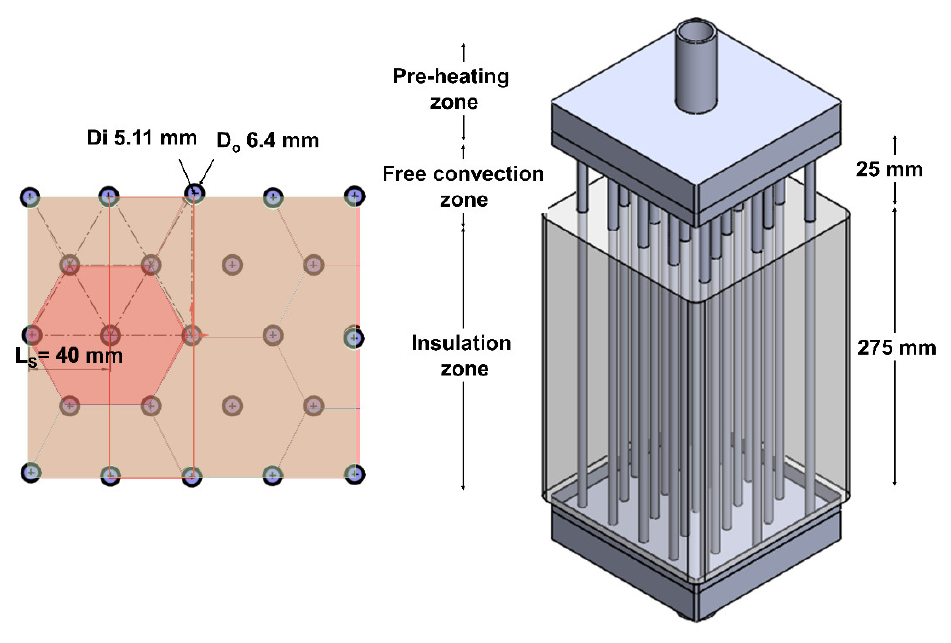
Figure 7. A schematic representation of the scaled-up multi-tubular fixed-bed reactor. Table 6. Dimensions and operating parameters of the scaled-up multi-tubular fixed-bed reactor.